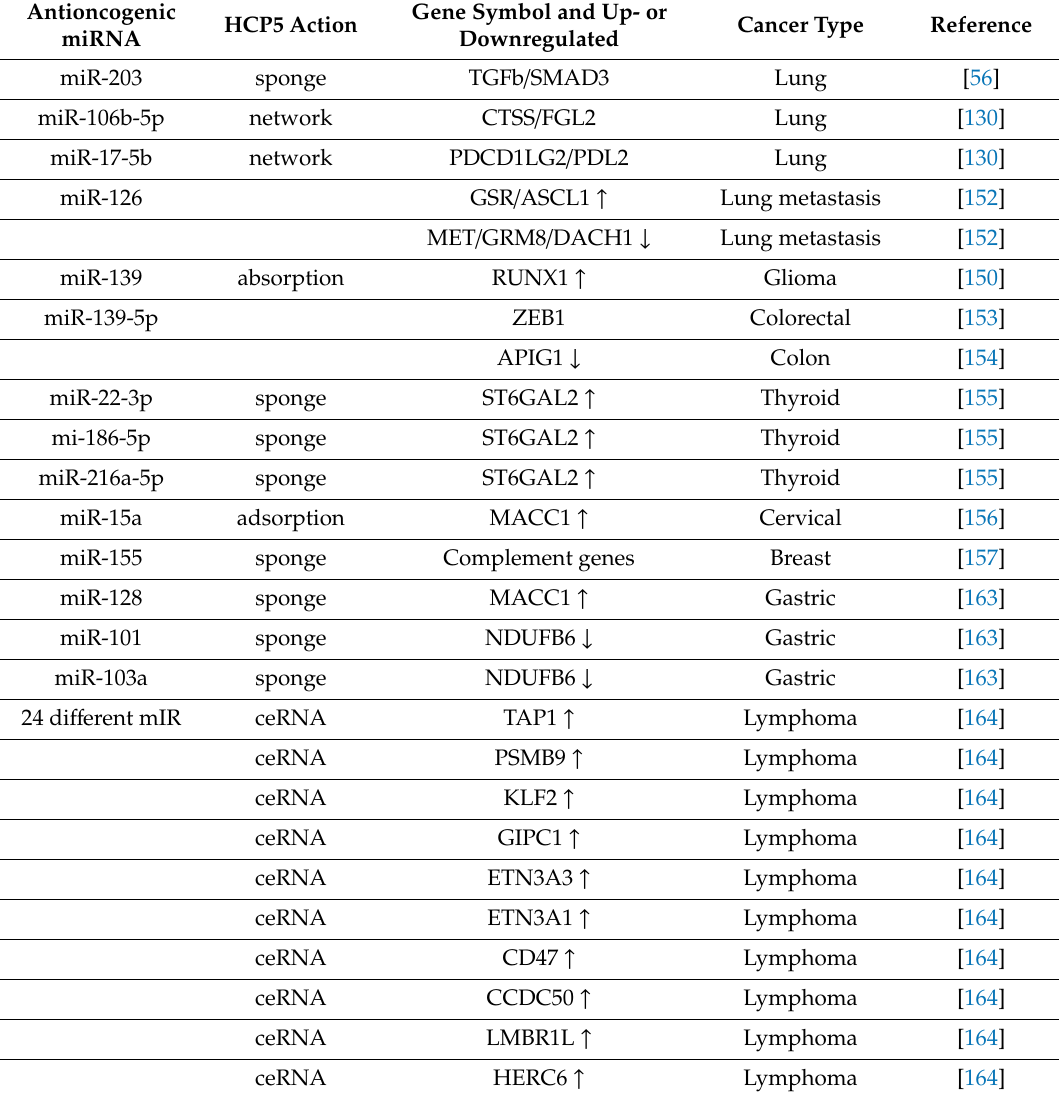
Table 6. HCP5 –miRNA–protein coding gene regulator